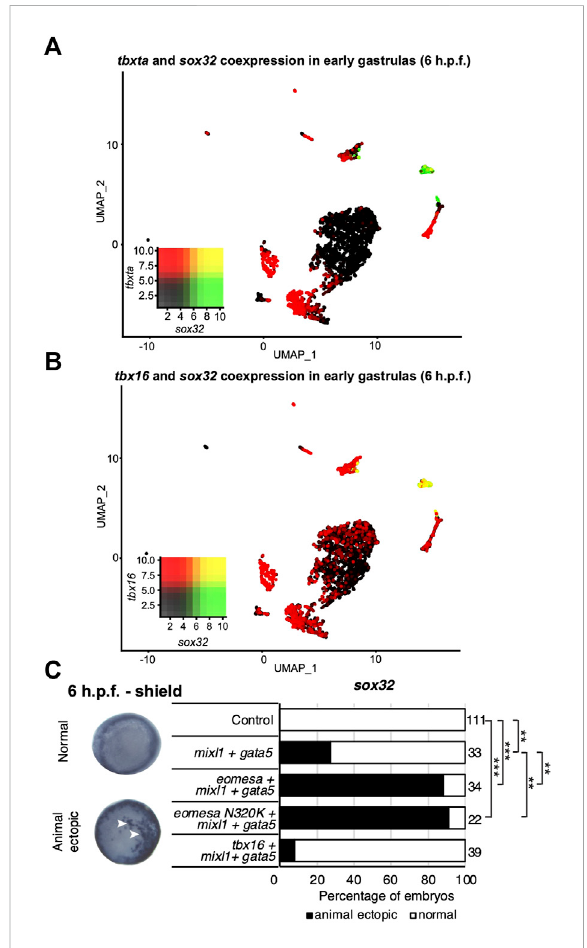
FIGURE 4 Tbx16 is substantially co-expressed with sox32 but cannot induce it in combination with mixl1 and gata5 . (A,B) UMAP clustering plots of whole embryo single-cell RNA-seq data in early gastrulas (6 h.p.f.) indicating co-expression of sox32 with tbxta and tbx16 . Heatmap insets indicate overall expression levels per gene and co-expression. Overlapping expression is shown in yellow. (C) WISH analysis of the ability of eomesa , eomesa N320K and tbx16 in combination with gata5 and mixl to induce sox32 expression at the animal pole of early gastrulas (6 h.p.f.). N = 2. Total numbers of embryos scored per condition are indicated. Representative images of expression patterns per gene per category are shown. Animal views; dorsal to the right. Arrowheads indicate ectopic expression. Fisher ’ s Exact two-tailed